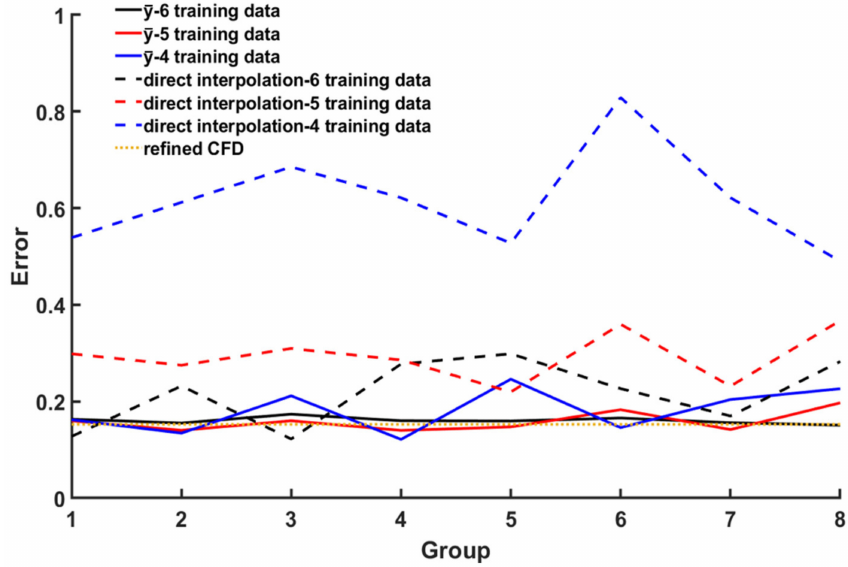
Figure 12. The MAE for the proposed method and direct PCHIP interpolation by different training data sets (i.e., 4, 5, and 6 wave periods) and pure refined CFD (i.e., 9 wave